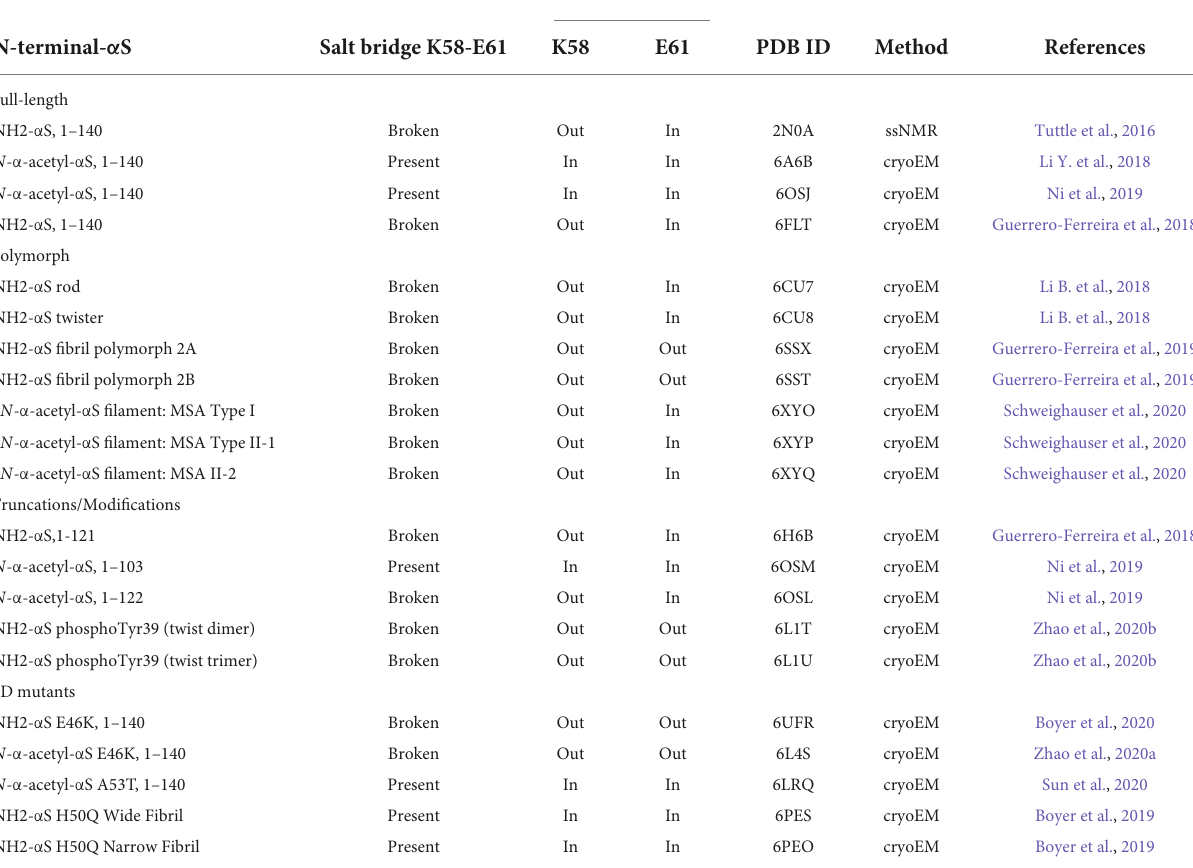
TABLE 2 Comparison of available α S fibril structures and an overview of K58-E61 salt